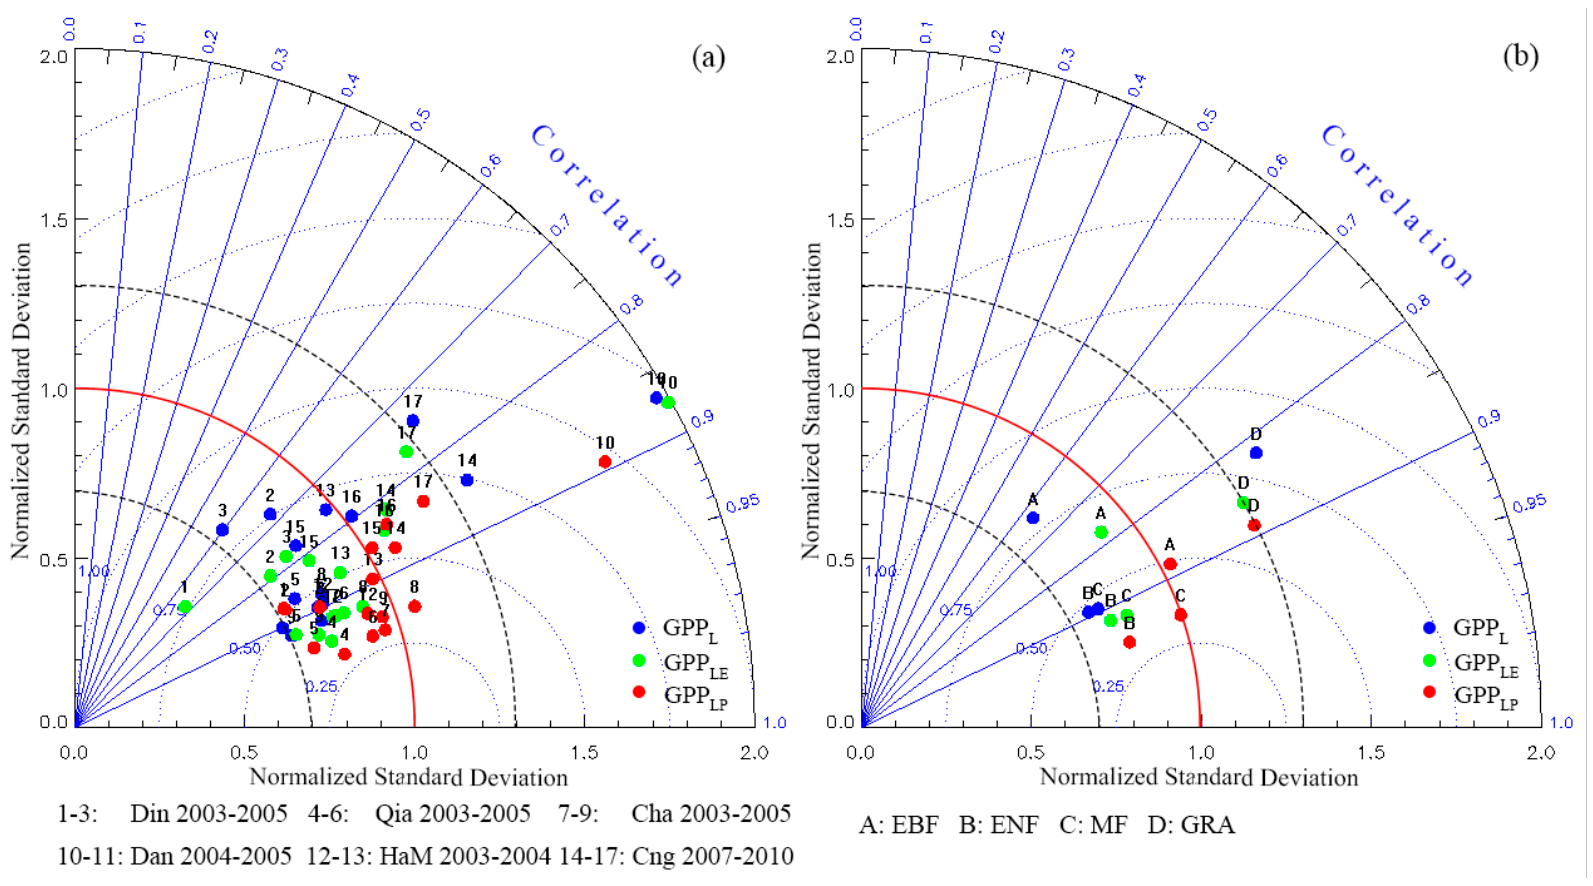
Figure 5. Statistics of three models (LPJ-DGVM, LPJ-EnKF and LPJ-POD) for the six selected tower sites (Table 1) by withholding the ( a ) site-year and ( b ) plant functional type (PFT) .